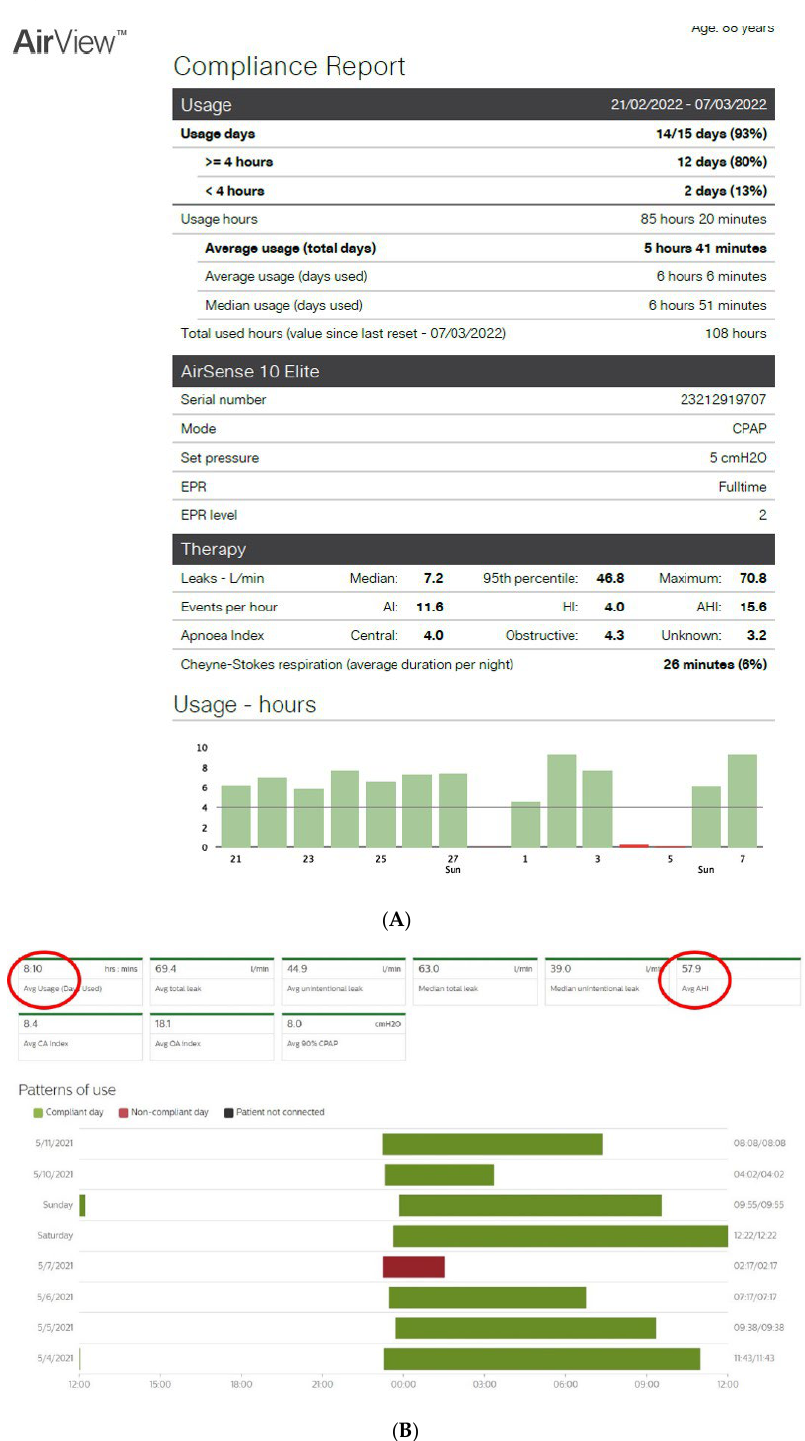
Figure 2. CPAP device data collection (( A ): Resmed; ( B ): Philips) over an 8-to-15-day period in patients exhibiting irregular use and residual respiratory events during sleep. AI: apnea index, HI: hypopnea index, AHI: apnea–hypopnea index, Avg: average, CA: central apnea, OA: obstructive apnea. Red circles highlight average usage and average residual